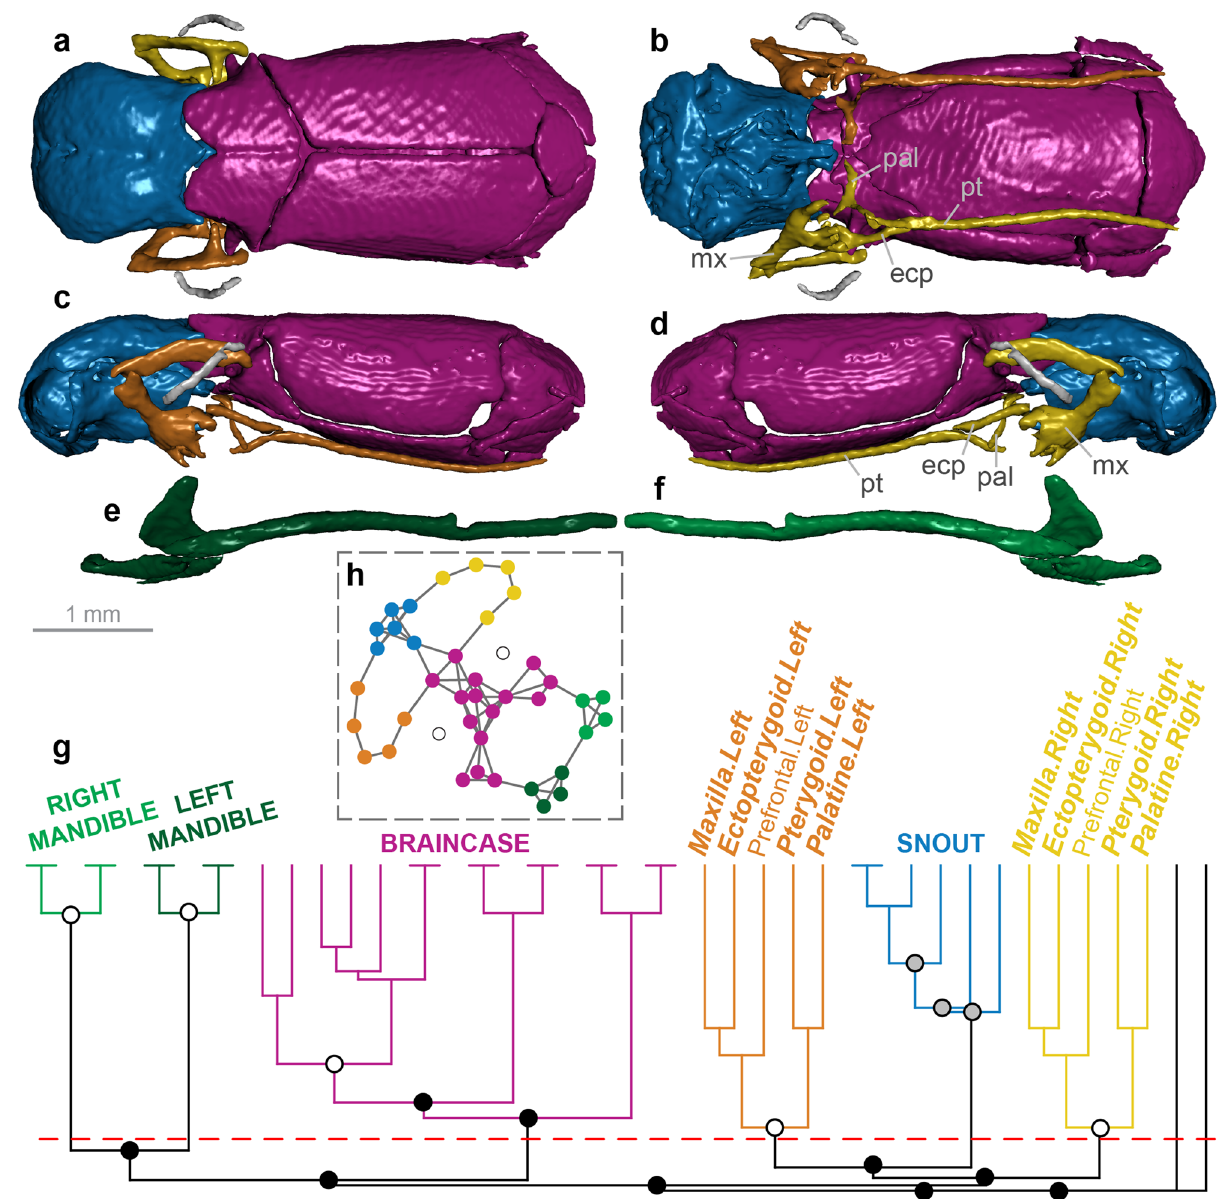
Figure 3. Skull modularity of anomalepidid scolecophidians. In anomalepidids, the ectopterygoids and maxillae always form left and right modules, typically alongside the other palatomaxillary elements (in italicized boldface) and the prefrontals. ( a–f ) Typical pattern of anomalepidid skull modularity, illustrated using Liotyphlops argaleus (MCZ R-67933) in ( a ) dorsal, ( b ) ventral, ( c ) left lateral, and ( d ) right lateral views of the skull, and ( e ) left lateral and ( f ) right lateral views of the mandible. ( g ) Network dendrogram of L. argaleus , reflecting this general anomalepidid network structure. Q-modules are indicated by Q max (represented by the red dotted line). S-modules are indicated by black (p < 0.001), grey (0.001 ≤ p < 0.01), or white (0.01 ≤ p < 0.05) circles. ( h ) Network representation of the skull of L. argaleus (see Supplementary Fig. S58 for labelled version). ecp ectopterygoid, mx maxilla, pal palatine, pt pterygoid. Dendrogram and network generated in R [v.4.0.3] 122 and RStudio [v.1.3.1093] 123 (see “Methods” section); specimen visualized in Dragonfly [v.4.1] 114 . MCZ scan data used by permission of the Museum of Comparative Zoology, Harvard